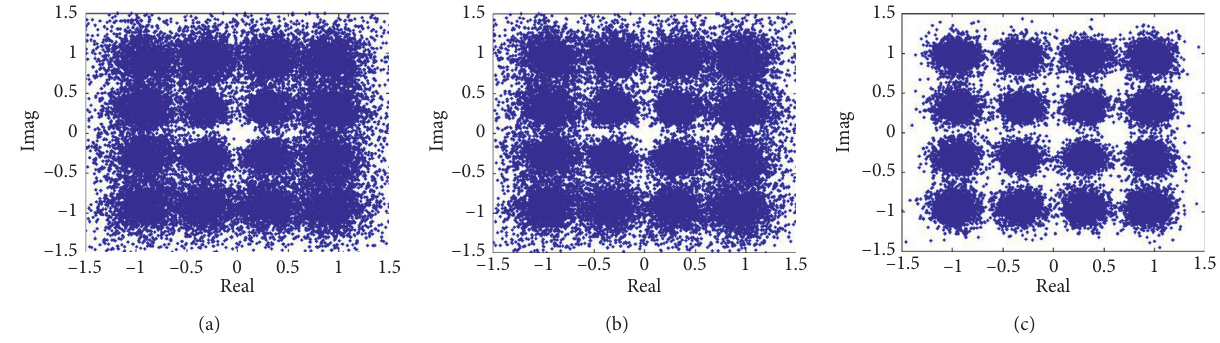
Figure 4: Constellation diagram based on channel estimation of three training